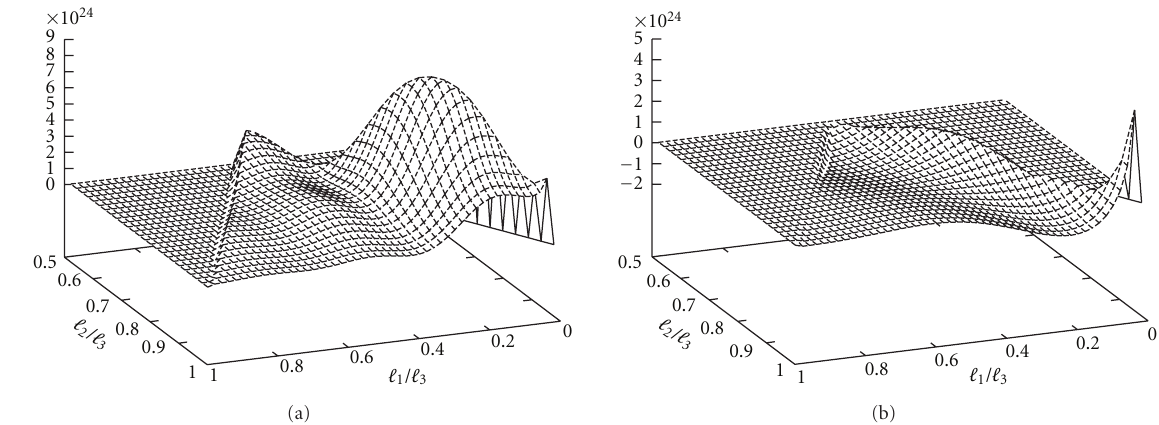
Figure 2: Same as Figure 1 for (cid:7) 3 = 1000. The acoustic oscillations are clearly seen.